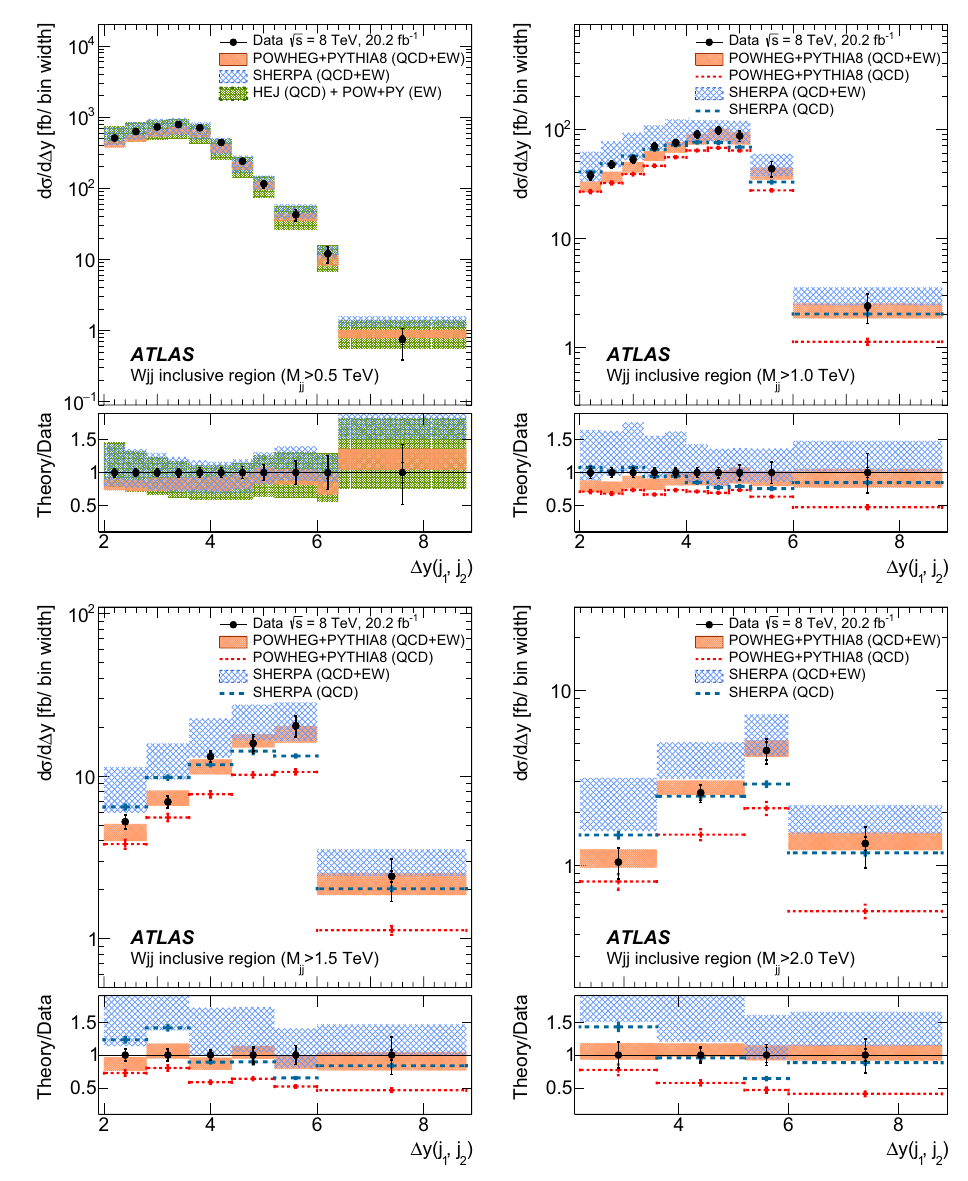
Fig. 32 Unfolded absolute differential W jj production cross sections as a function of (cid:6) y ( j 1 , j 2 ) for the inclusive fiducial region with pro- gressively increasing dijet mass thresholds. Both statistical ( inner bar )